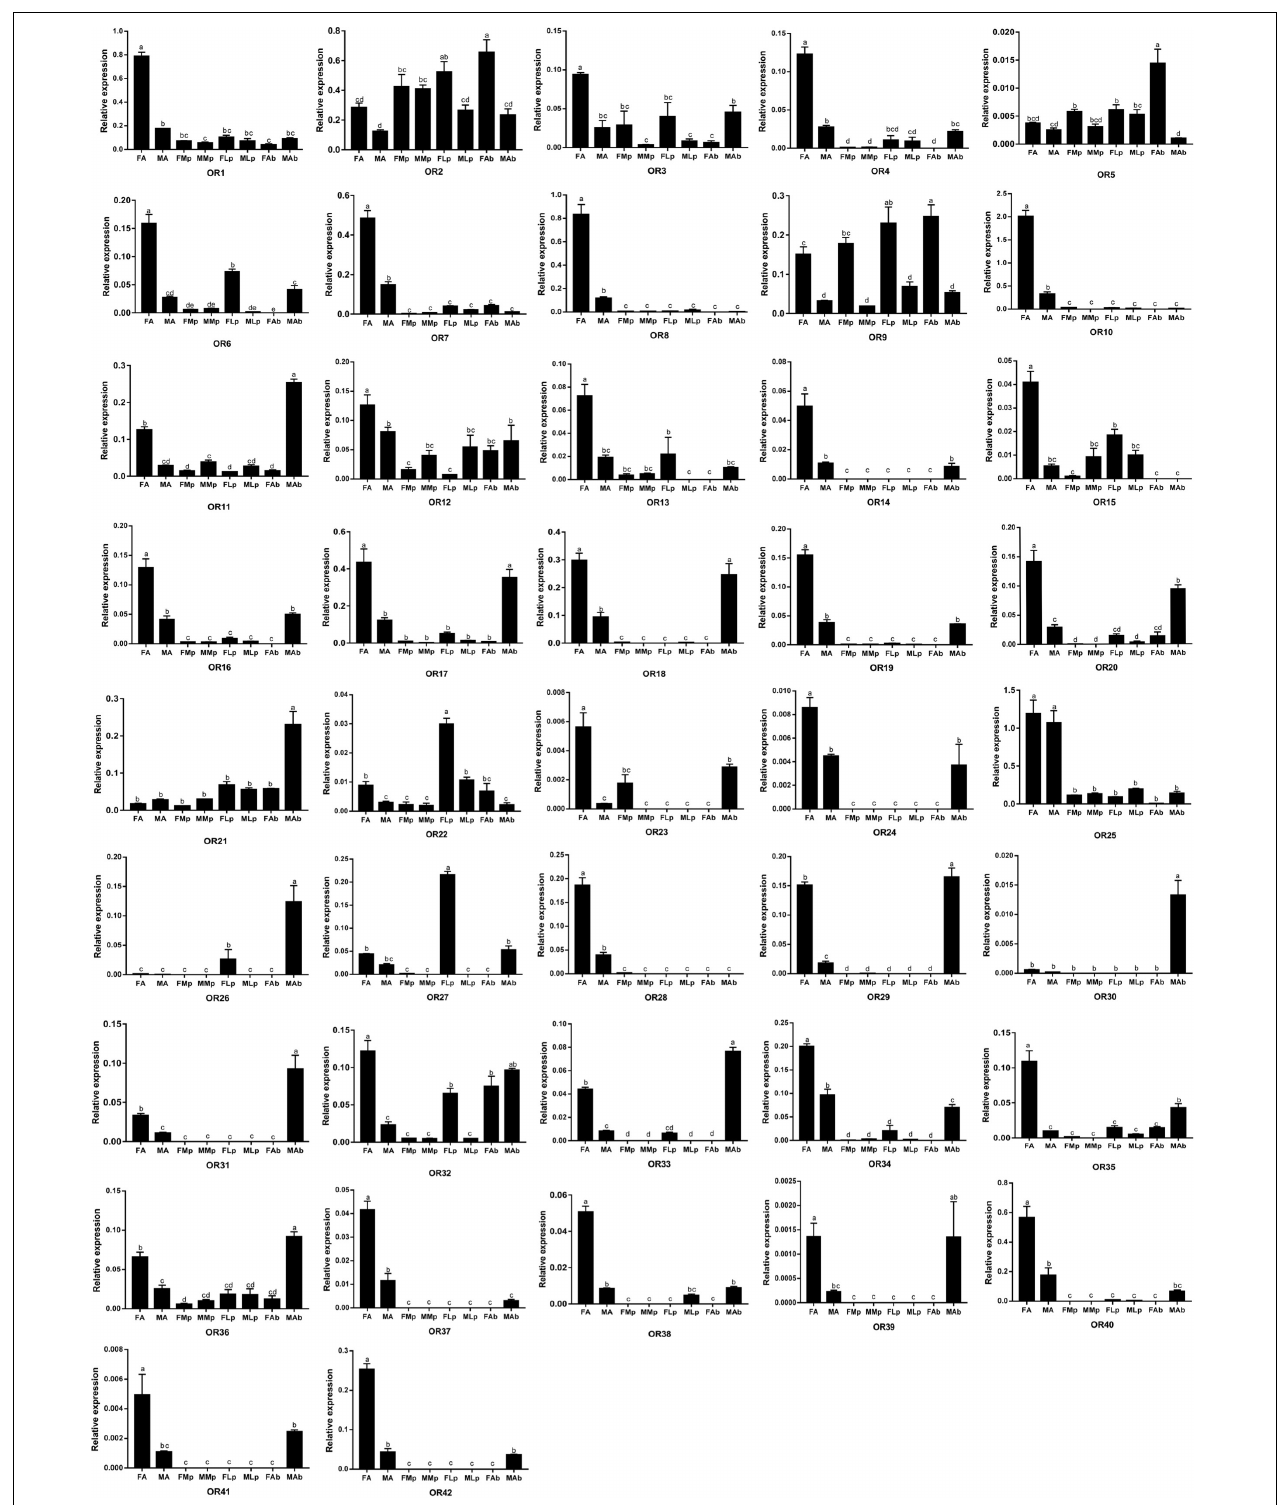
FIGURE 5 | Relative mRNA expression of AgerORs in Apriona germari tissues. The relative mRNA levels were normalized to those of the actin gene and analyzed using the Q-gene method. All values are shown as mean ± SEM normalized. The data were analyzed by least significant difference test after one-way analysis of variance. Different letters (a–e) indicate significant differences between means ( P < 0.05). FA, female antennae; MA, male antennae; FMp, female maxillary palps; MMp, male maxillary palps; FLp, female labial palps; MLp, male labial palps; FAb, female abdominal end; MAb, male abdominal end.